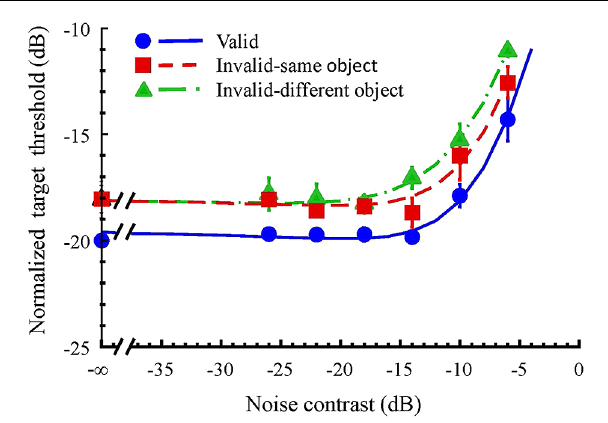
FIGURE 2 |Target threshold versus noise contrast functions. Each data point represents the average of the normalized threshold from three observers.The blue circles and the solid curve denote theTvC function for the valid condition; the red squares and the dashed curve, the same-object condition; the green triangles and the dash-dot curve, the different-object condition.The smooth curves are fits of the model discussed in the text. The error bars are the estimated one standard error of normalized individual